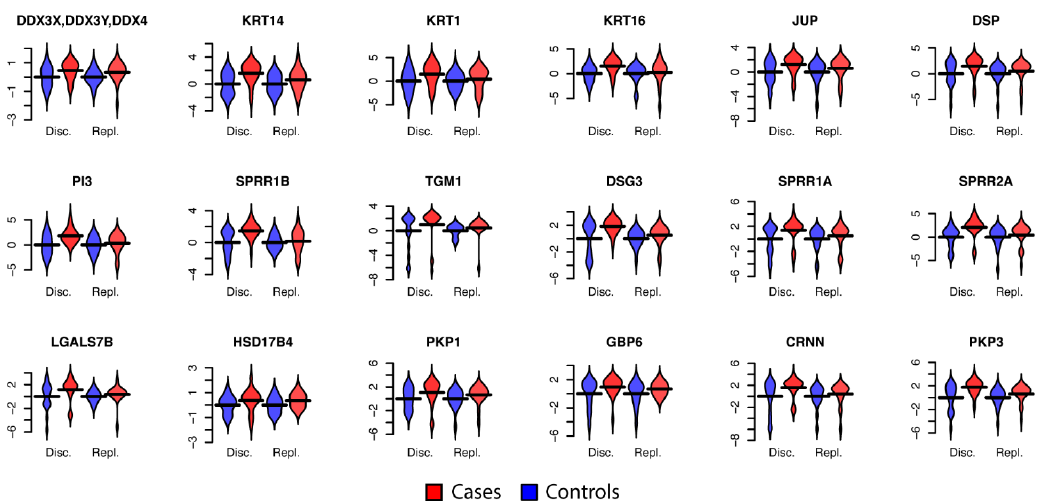
Figure 2. Distribution of protein abundance in women with CIN2+ (Cases) and women with HPV-negative samples (Controls). Protein abundance levels (log2) in both discovery and replication cohorts for the 18 proteins with a nominally significant p -value ( p < 0.05, Wilcoxon test) in the discovery cohort. Protein abundance levels are shifted by the mean of the controls in the discovery and replication cohorts, respectively. This shifts the mean of the controls to 0 with the increased levels in cases easily visible.